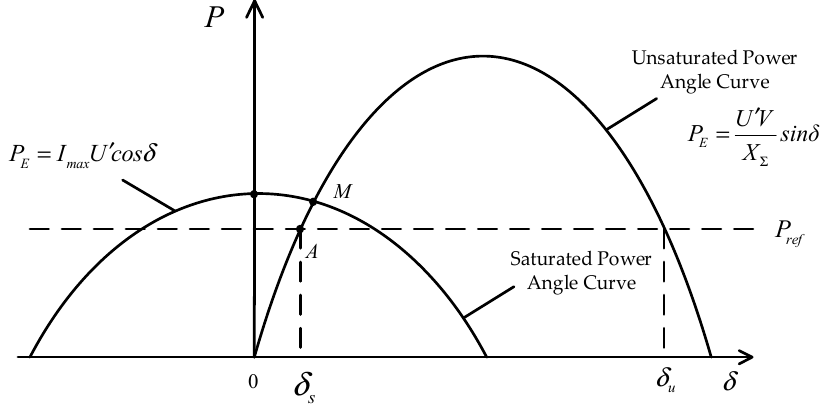
Figure 4. Power angle curve of droop-controlled converter.